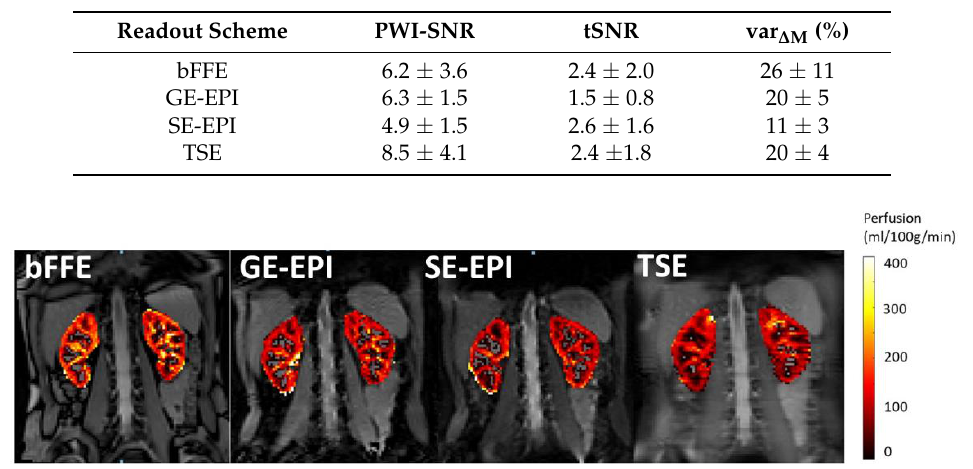
Figure 4. Example perfusion maps for each readout scheme (bFFE, GE-EPI, SE-EPI, and single-shot TSE) from a single subject shown for the central slice. Note the higher perfusion signal of the bFFE scheme due to contributions from the arcuate arteries of the kidney. Table 2. Perfusion-weighted image signal-to-noise ratio (PWI-SNR), temporal SNR (tSNR), and variability of the perfusion-weighted signal (var ΔM ) for each scheme.